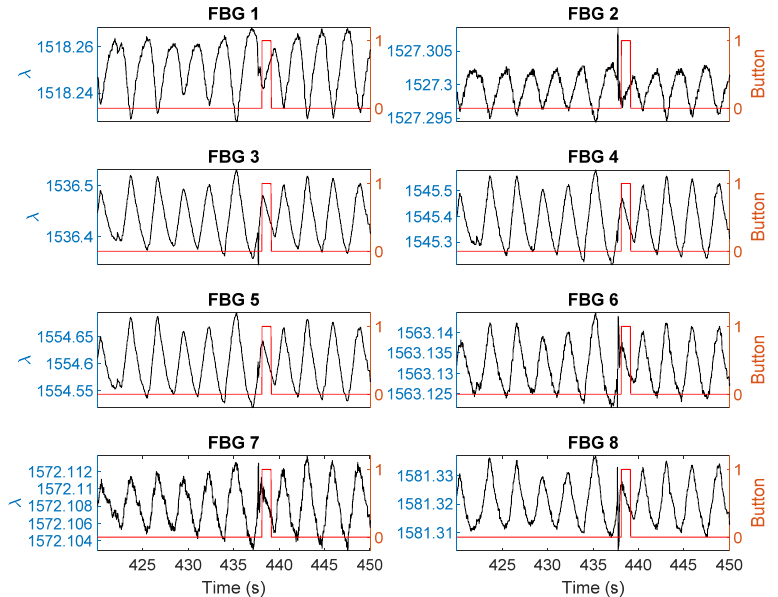
Figure 8. Experimental results for the eight FBG sensors for 30 s showing the breathing signals are distorted due to a fetal movement at 438 s. The black line with the left y axis shows the response of the sensor. The red line with the right y axis shows the mother’s perception.